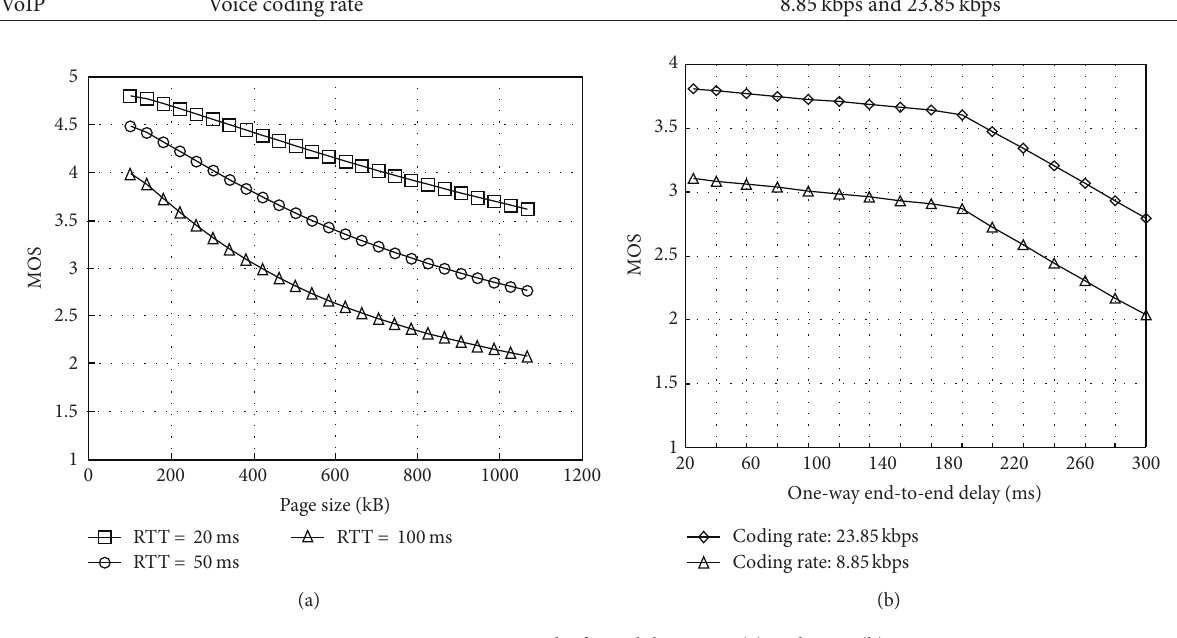
F 4: Average MOS results for web browsing (a) and VoIP